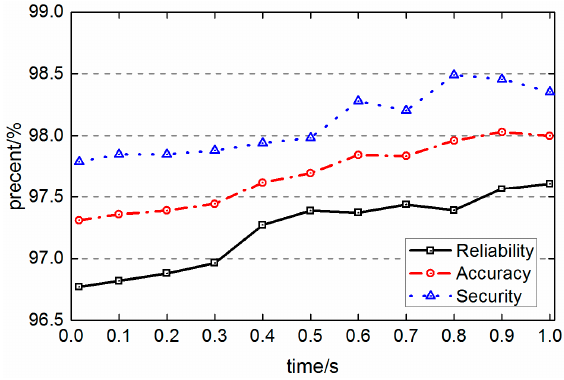
Figure 16. Performance of different SVM ‐ based ensemble classifier using different response times.